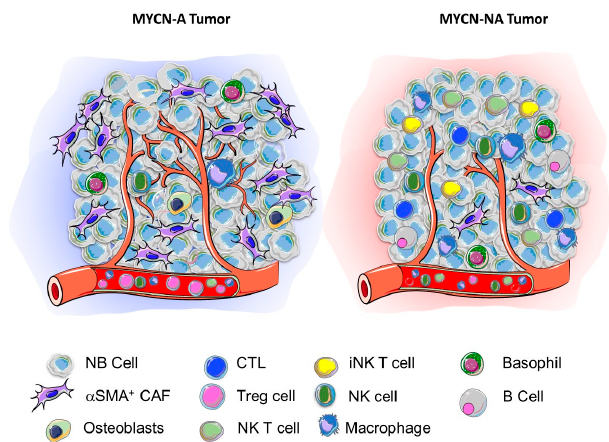
Figure 1. Contribution of MYCN to the TNME landscape in NB. Schematic representation of the TME landscape of a MYCN-A (cold) and a MYCN-NA (hot) tumor based on the review of the literature summarized in Table 1.